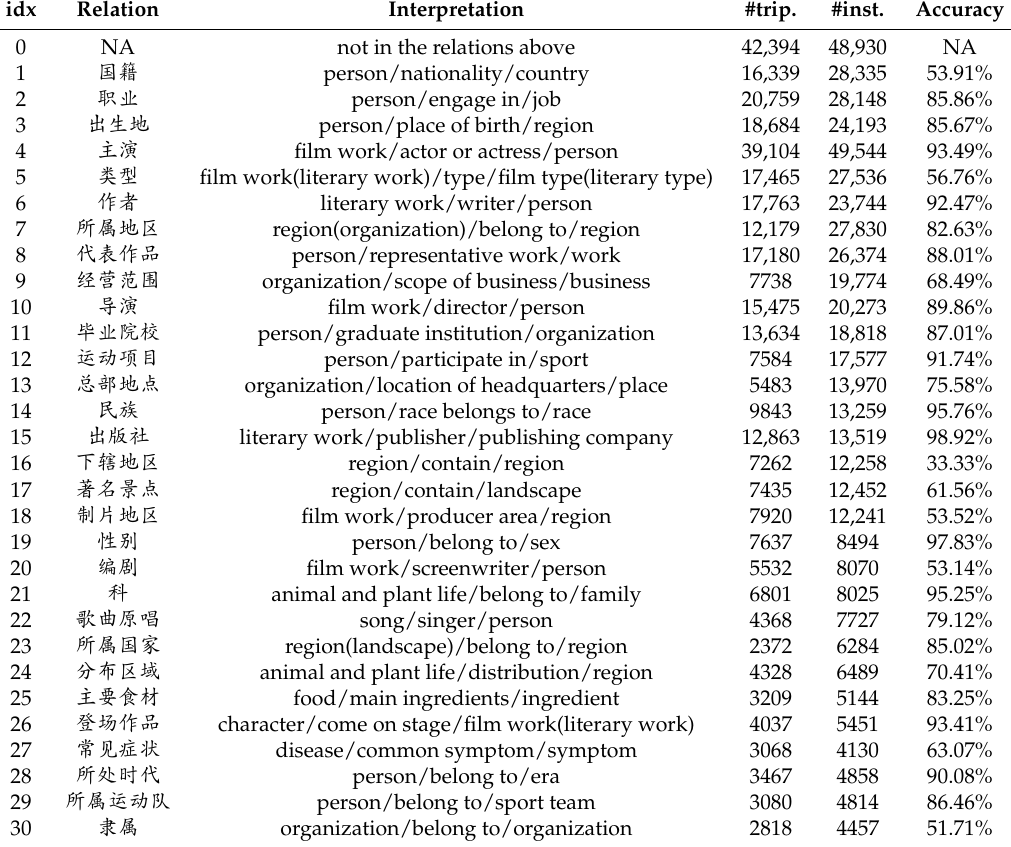
Table 1. Information of proposed